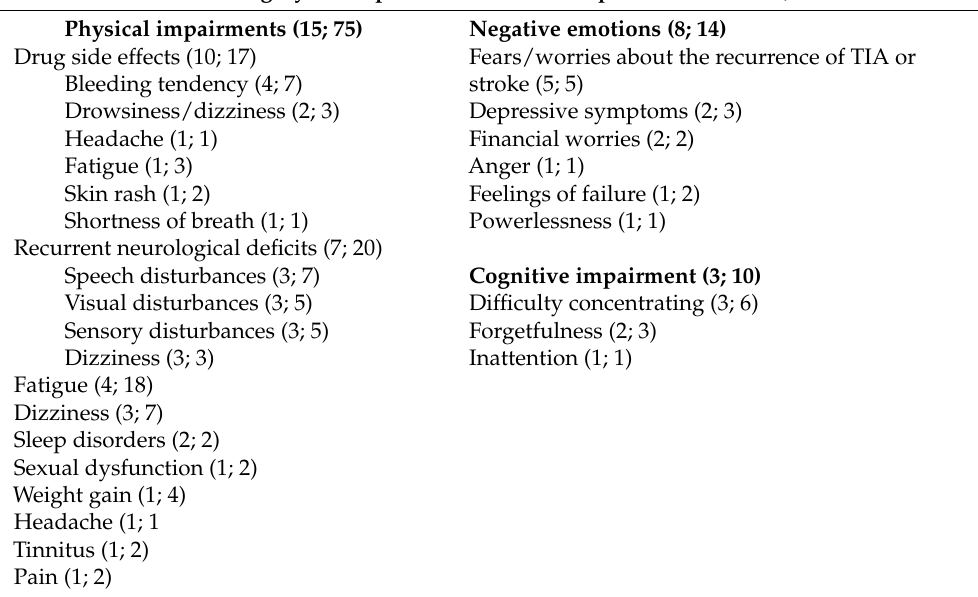
Table 2. Main categories, categories, and themes resulting from semiquantitative analysis of interview statements from TIA patients three months after TIA ( n = 17). In round brackets, the first number: Number of TIA patients, who named aspects of main categories, categories, and themes. In round brackets, the second number: Number of the corresponding codes. Main Category A “Impairments as a Consequence of TIA” (15;